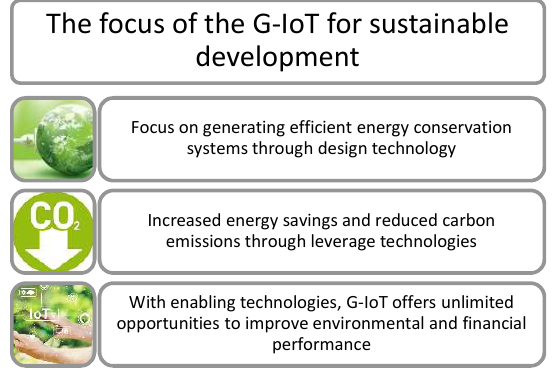
Figure 2. G-IoT focus on sustainable